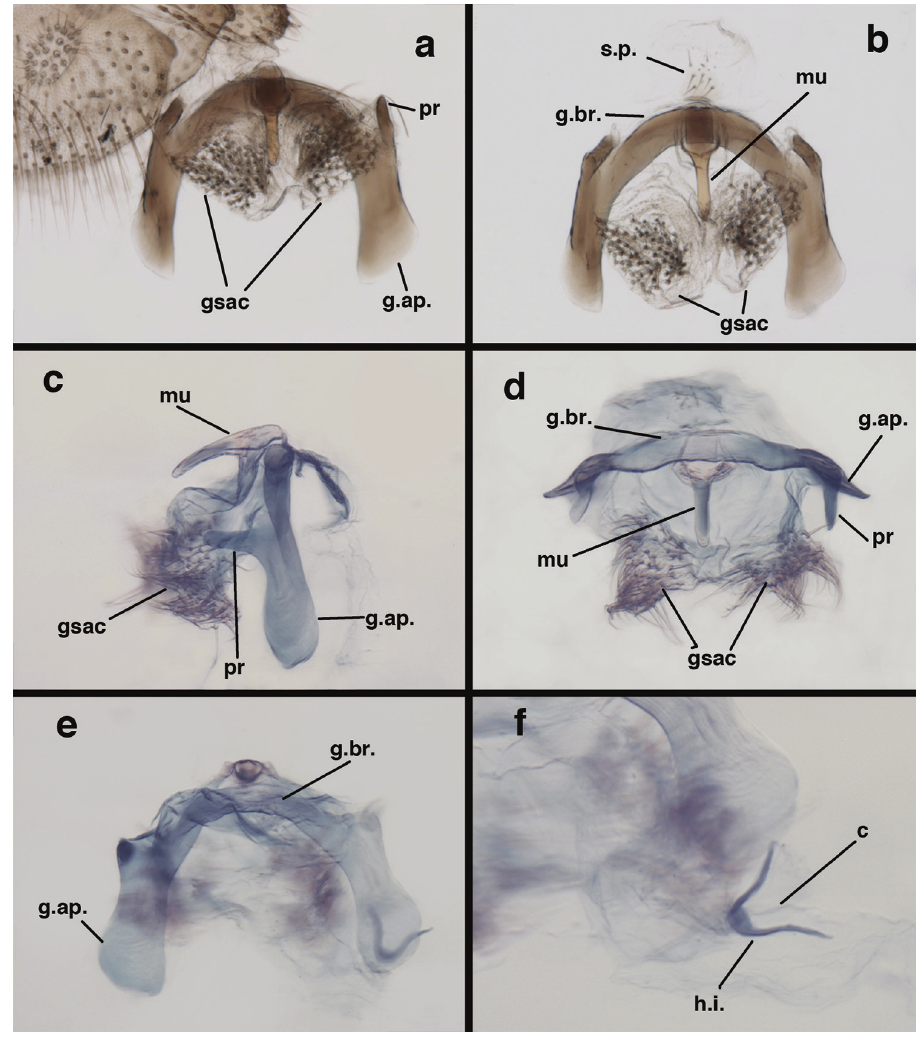
Figure 29. Ungla demarmelsi Sosa: Male genitalia, ( a ) gonarcus, frontal, gonosaccus inverted ( b ) gonar- cus, frontal, gonosaccus everted ( c ) gonarcus, lateral ( d ) gonarcus, dorsal ( e ) gonarcus, posterior, with hypandrium internum caught beneath apodeme on right ( f ) hypandrium internum. c comes gsac gono- saccus g.ap. gonarcal apodeme g.br. gonarcal bridge h.i. hypandrium internum mu mediuncus pr un- articulated process on frontal margin of gonarcal apodeme s.p. setose subanal plate ( a, b Venezuela, Distrito Capital, USNM; c–f Venezuela, Mérida, UCDC).